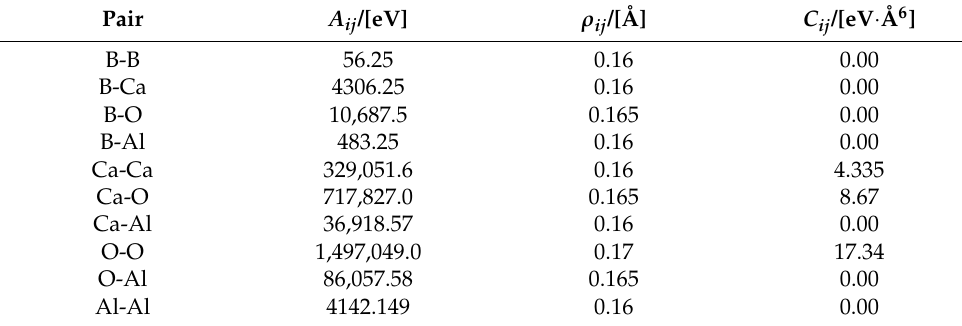
Table 1. Buckingham potential parameter of particle pairs in this study.